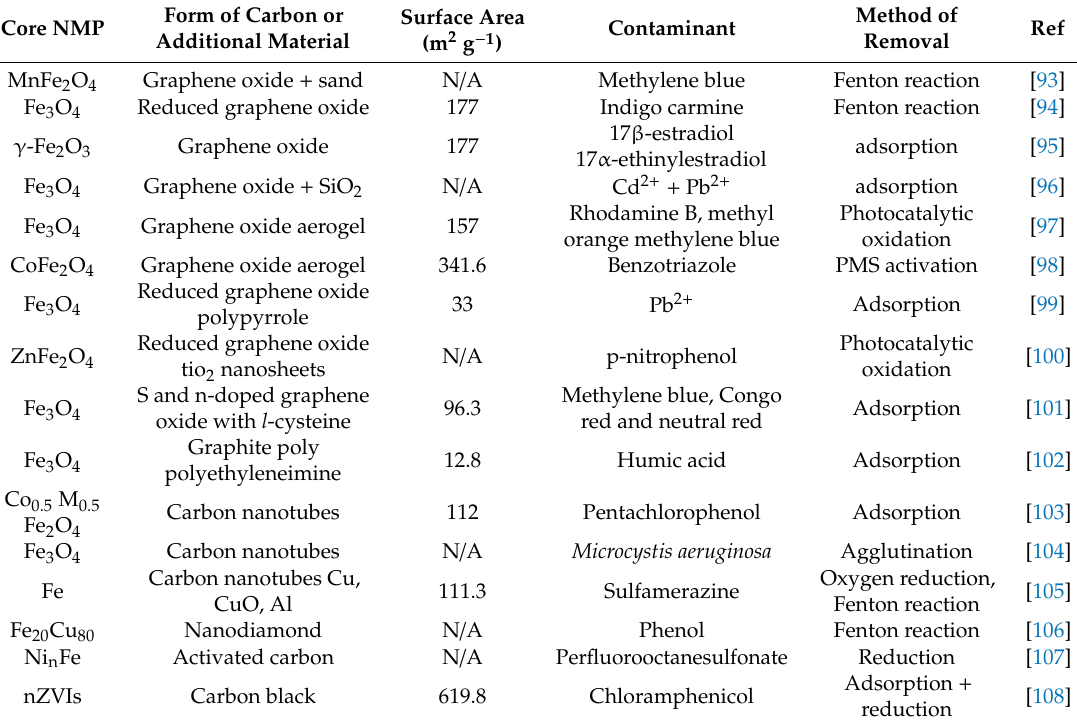
Table 5. Magnetic nanocomposites with carbon species for removal of